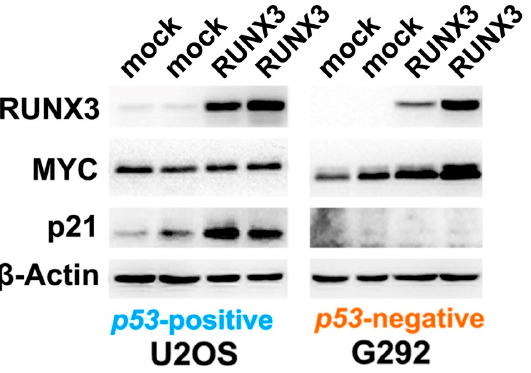
Figure 2. Exogenous RUNX3 upregulates p21 but not MYC in p53 -positive U2OS cells, but conversely upregulates MYC but not p21 in p53 -negative G292 cells. The data are modified from Otani et al. (2022) [32].